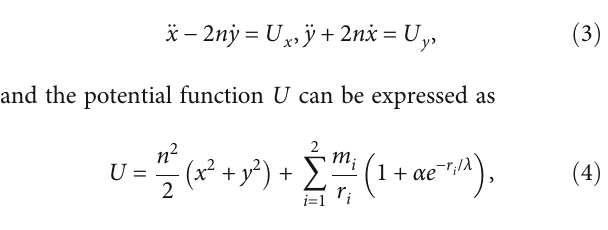
λ for α > 0 c versus